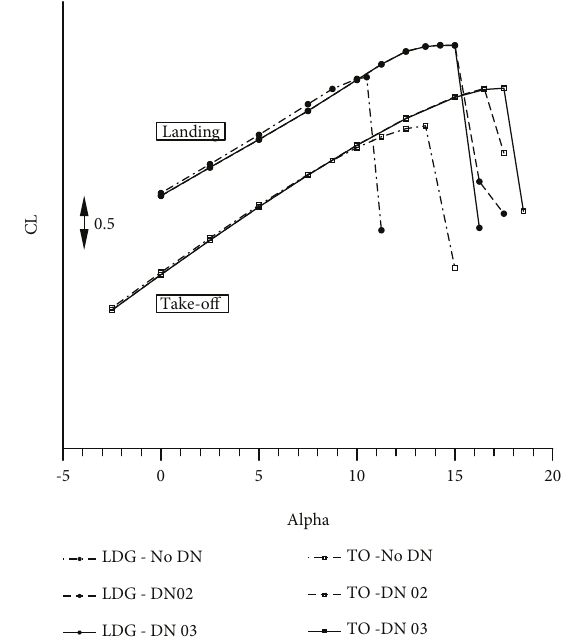
Figure 24: E ff ect of a droop nose on high-lift computed 2D performance at the outboard wing